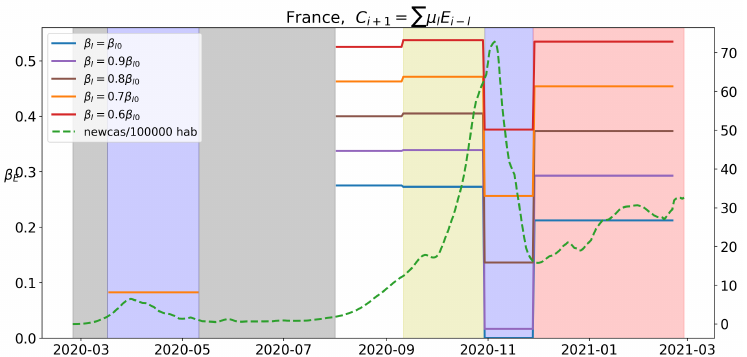
Figure 2. Value of β E for the different levels of lockdown. Different k-values for reducing the β I are tried. Blue background will correspond to Stage 1, red to Stage 2, yellow to Stage 3 and white to Stage 4. A green dotted line corresponds to the value of new cases per 100,000 hab.